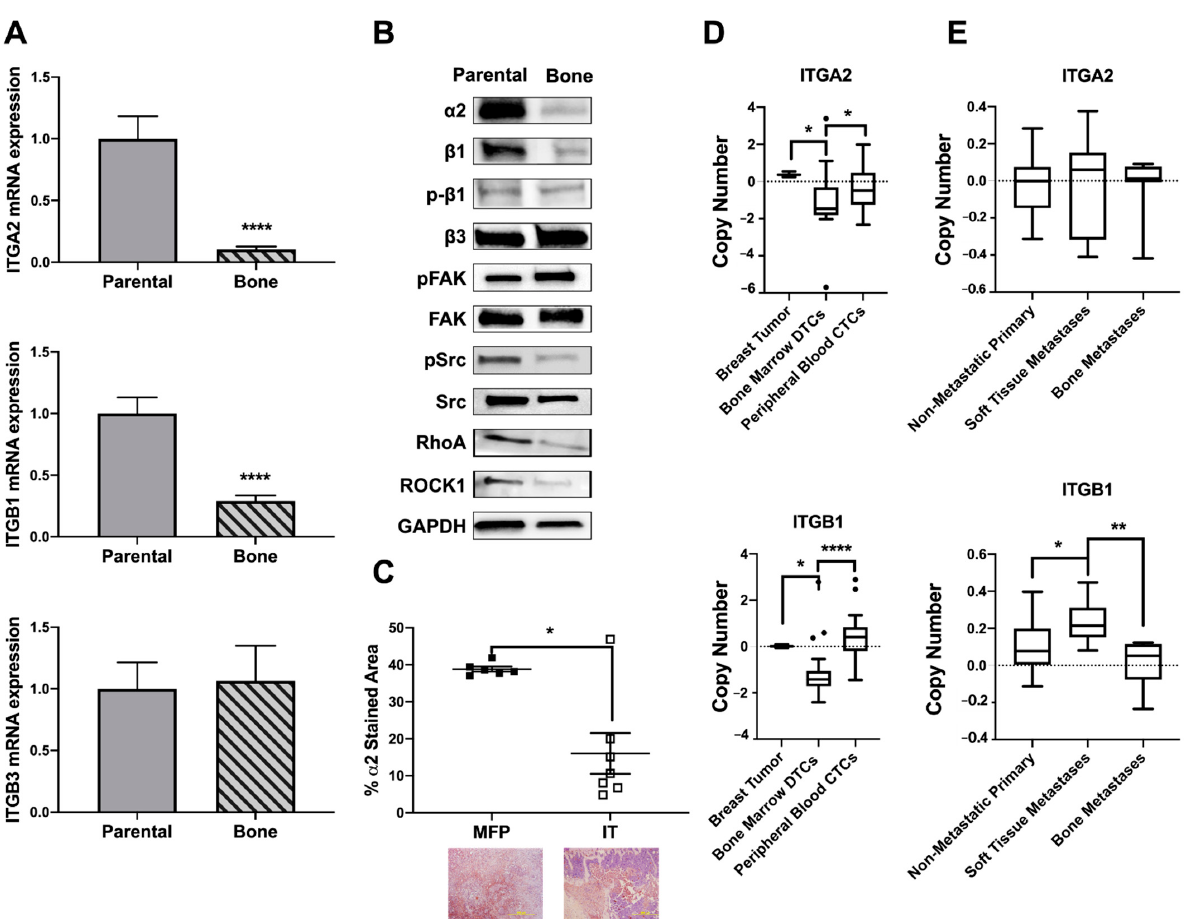
Figure 4. ( A , B ) A bone metastatic clone of MDA-MB-231 (Bone) and the parental MDA-MB-231 cells (Parental) were ana-